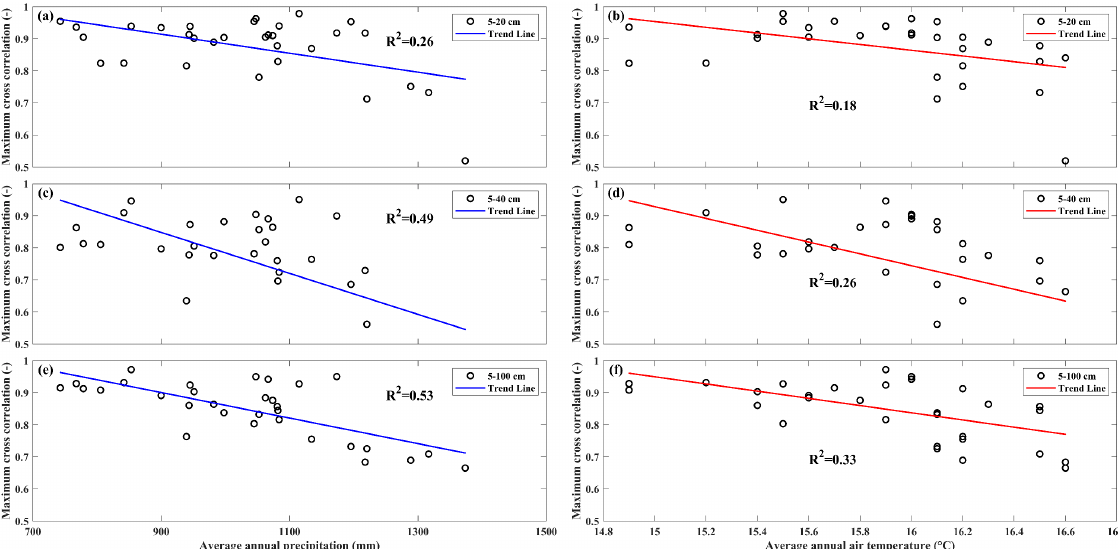
Figure 4. The left panel ( a , c , e ) shows the scatter plots between maximum cross correlation coefficient and average annual precipitation over in situ stations, the right panel ( b , d , f ) is for maximum cross correlation coefficient and average annual air